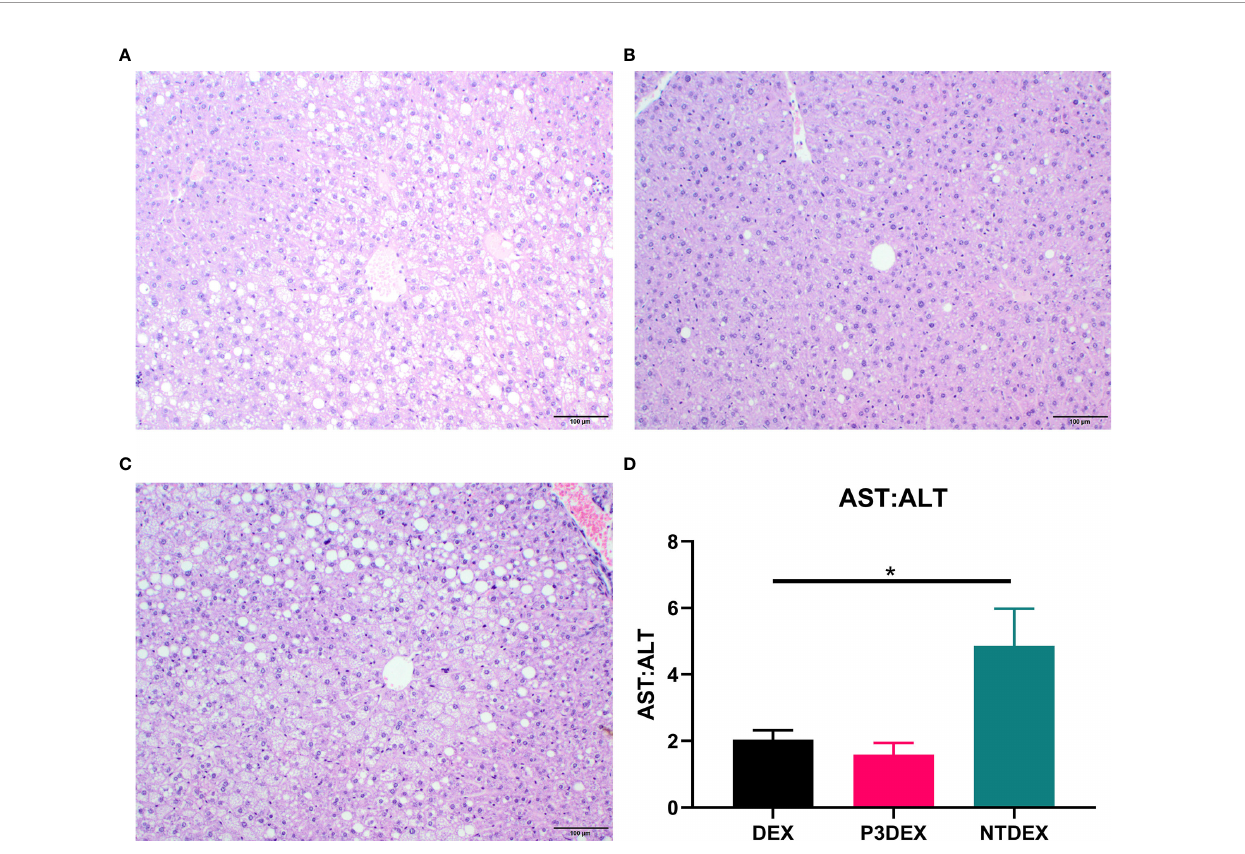
FIGURE 6 | LNFPIII conjugates reduce hepatic lipid accumulation and liver damage. Liver sections from DIO mice treated with (A) DEX, (B) P3DEX, or (C) NTDEX. (D) Ratio of circulating AST:ALT. One-way ANOVA with Dunnett ’ s Multiple Comparisons Test. *indicates a signi fi cant difference (p ≤